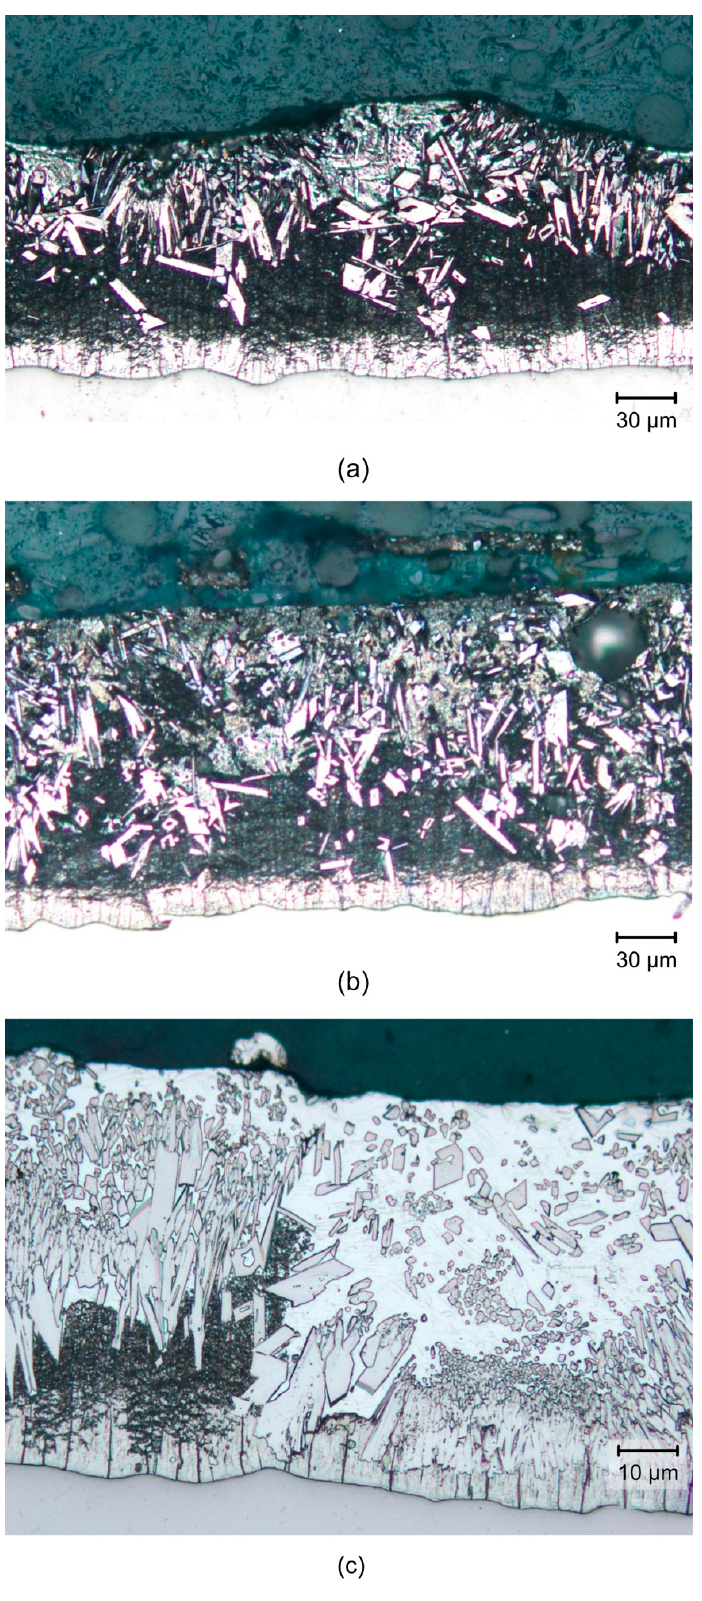
Figure 3. Photomicrographs of the structure of the coating on the surface of the tested high-strength steel specimens, formed by the process of hot-dip galvanizing: ( a ) HARDOX 600, ( b ) ARMOX 500, ( c ) DOMEX 700.